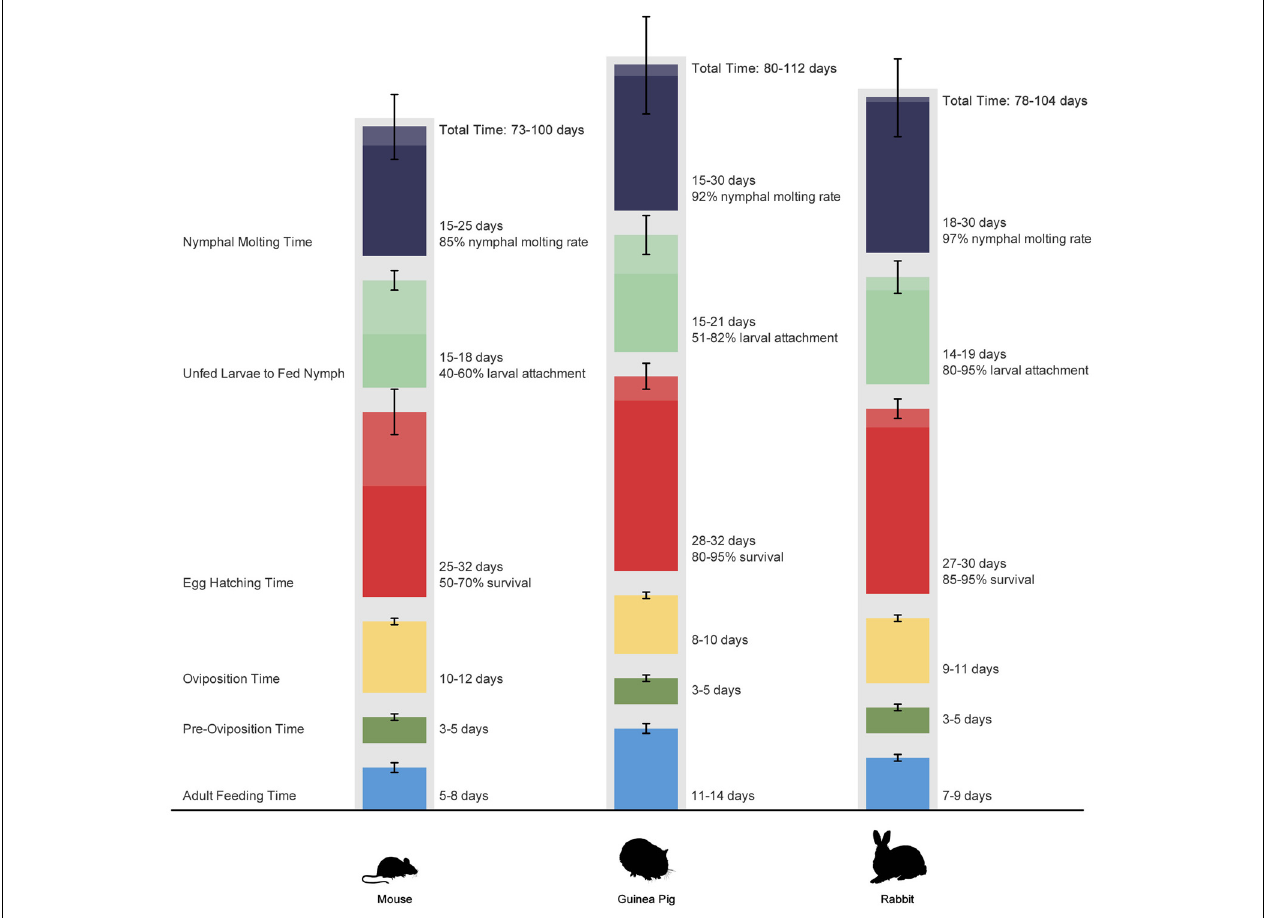
FIGURE 2 | Life cycle of Hyalomma marginatum under laboratory conditions when feeding on mice, guinea pigs, and rabbits. Colored segments represent time periods required for different life stages. Bars represent range of values. Values were not compared